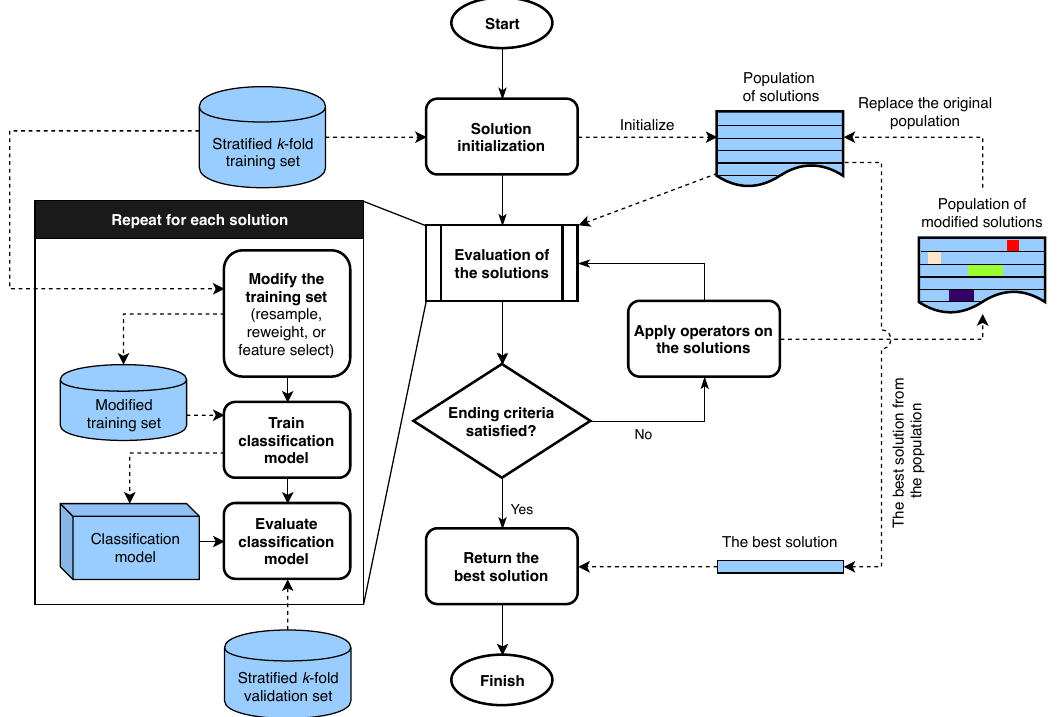
Figure 4. The optimization process of preprocessing data with nature-inspired optimization methods in